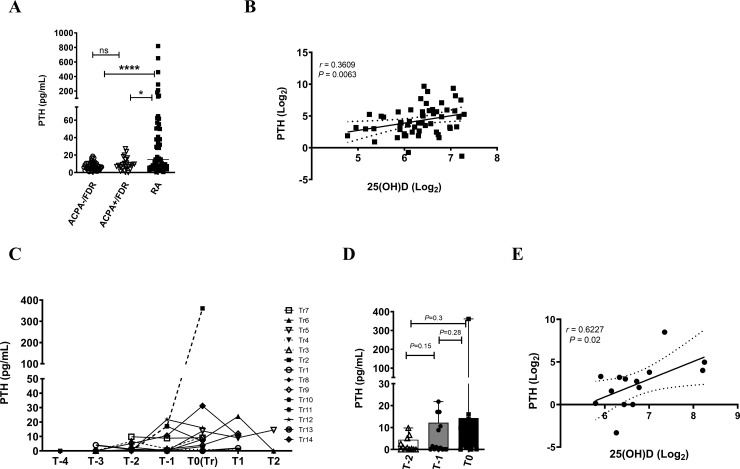
Longitudinal and cross-sectional analysis of PTH.(A) Scatter plot showing the distribution of circulating PTH levels in ACPA-/FDR, ACPA+/FDR and RA patients. Data was analyzed by Kruskal-Wallis test with Dunn’s post-hoc test (****P<0.0001; *P<0.05; ns = non-significant) (B) Scatter plot showing Spearman rank correlation analysis between PTH and 25(OH)D levels in RA patients. (C) Line graph showing the evolution of PTH levels over-time in progressors (N = 14) prior to RA onset (T-1 to T-4), at the time of clinical diagnosis of RA onset (T0) and post-onset (T1 and T2) (B) Box-Whiskers plot showing the distribution of PTH at two time points prior to RA onset (T-1 and T-2) and at transition point (T0). Data was analyzed by repeated measures ANOVA using Greenhouse-Geisser model. (E) Scatter plot showing Spearman rank correlation analysis between PTH and 25(OH)D levels in progressors at time of RA onset (T0).